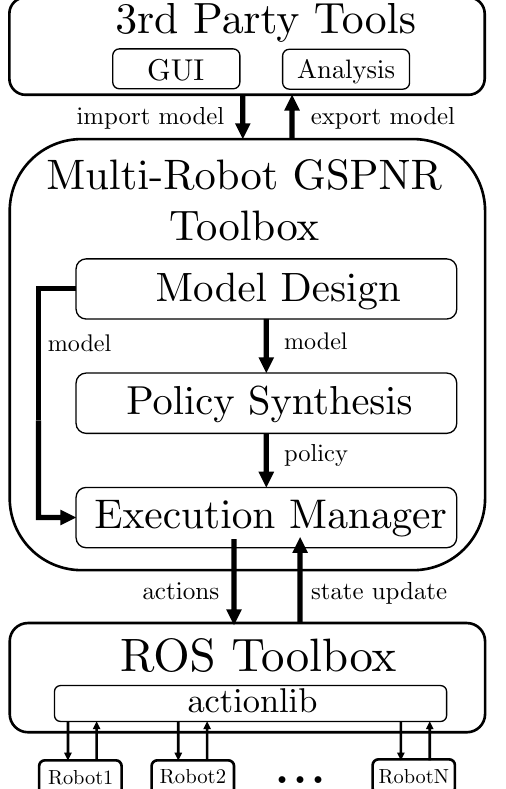
Figure 2. MATLAB ® GSPNR Toolbox architecture interfaced with peripheral